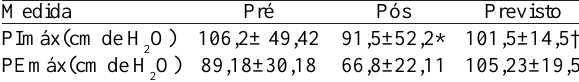
Tabela 2. Comportamento da força muscular respiratória.